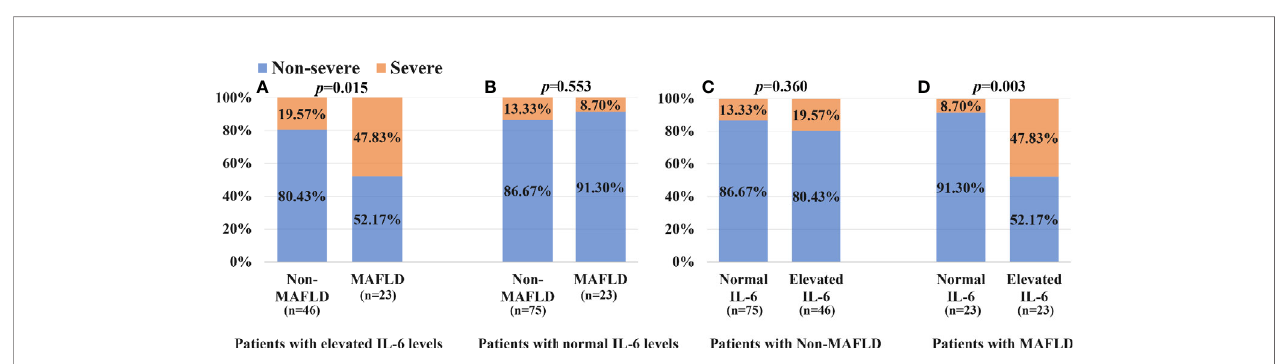
FIGURE 4 | Association between IL-6 levels, MAFLD status and COVID-19 severity: (A) patients with elevated IL-6 levels; (B) patients with normal IL-6 levels; (C) patients with Non-MAFLD; (D) patients with